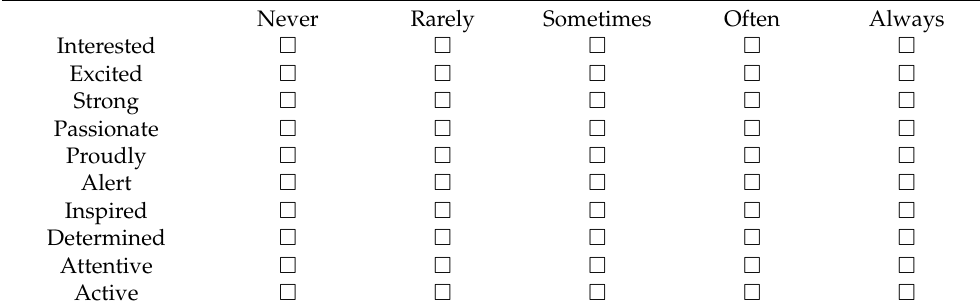
Table 2. The positive emotion scale.